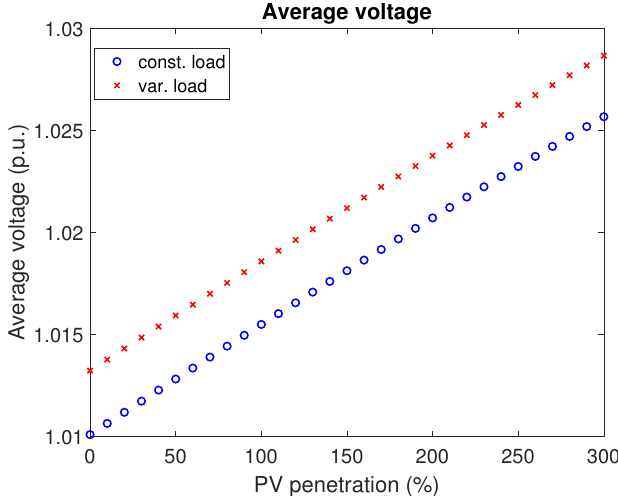
Figure 8. Averaged voltage across all buses and over a week.